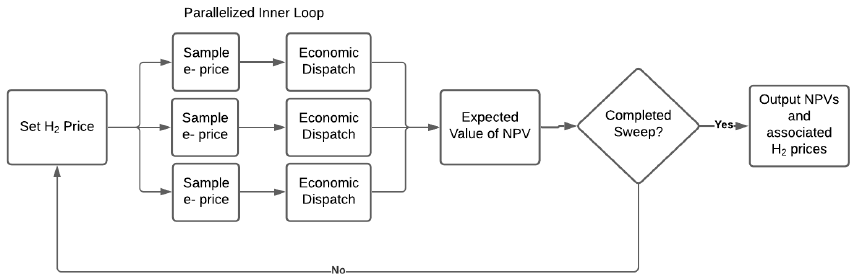
Figure 2. Algorithm used in the HTTR-GT/H 2 price-taker dispatch model. The model can run a different inner loop for each stochastic time history in order to generate an expected net present value.